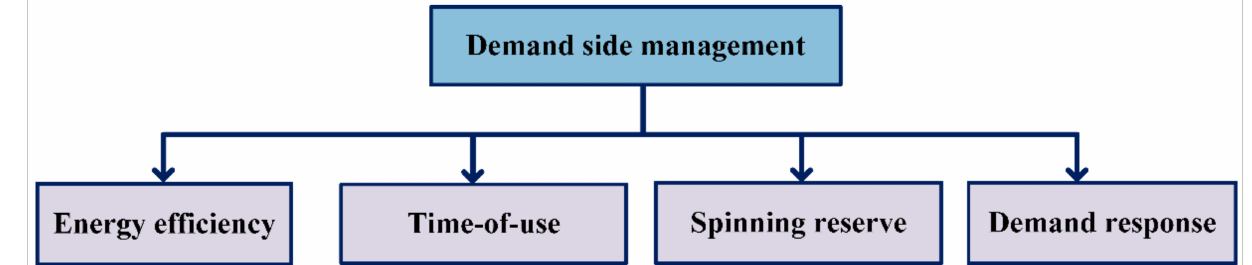
Figure 3. Basic principle of